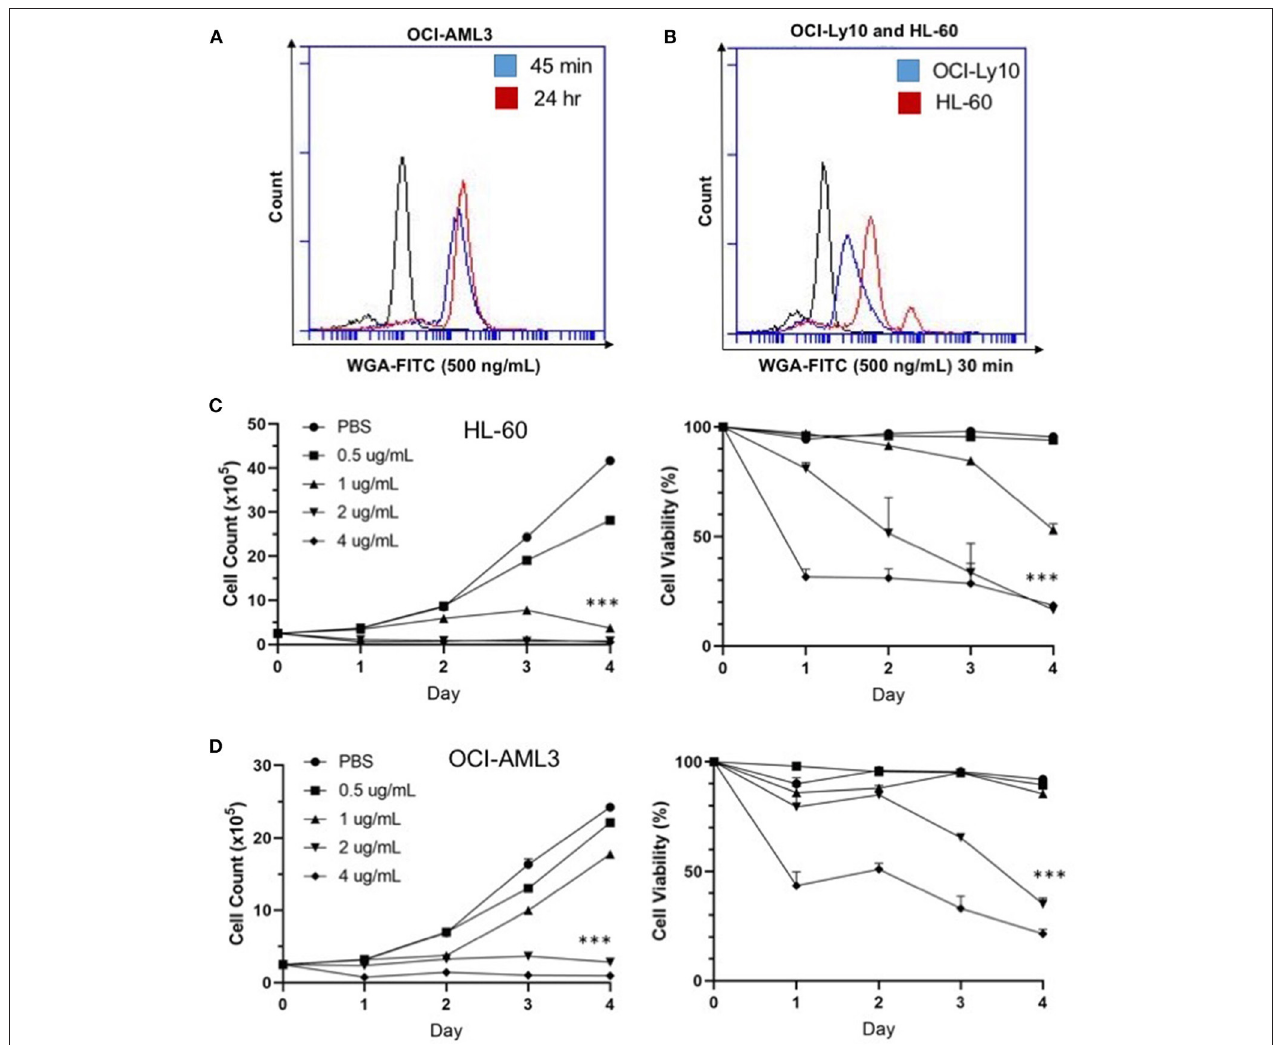
FIGURE 2 | WGA binds and kills in a dose- and time-dependent manner. (A) OCI-AML3 cells treated with WGA-FITC (500ng/mL) and analyzed for binding using flow cytometry. Binding to cells at 45min (blue peak) and 24h (red peak) compared to control (black peak). (B) OCI-Ly10 and HL-60 cells treated with WGA-FITC (500ng/mL) for 30min and analyzed for binding using flow cytometry. (C,D) Viable cell count and percent viability of HL-60 (C) and (D) OCI-AML3 with WGA treatment (0.5, 1.0, 2.0, and 4.0 µ g/mL) for 1–4 days, counted using trypan blue. *** p < 0.001.